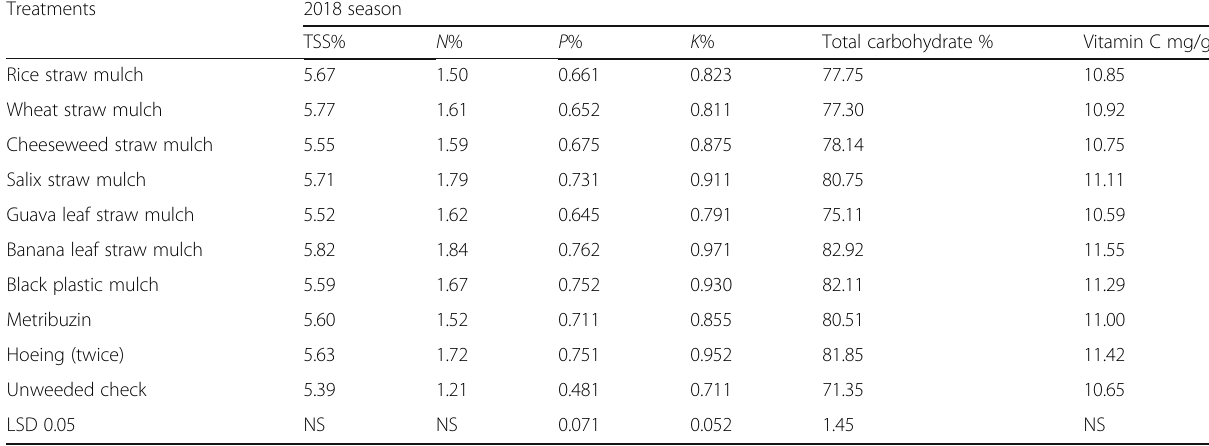
Table 7 Effect of different weed control treatments on tuber quality of potato during 2018 season